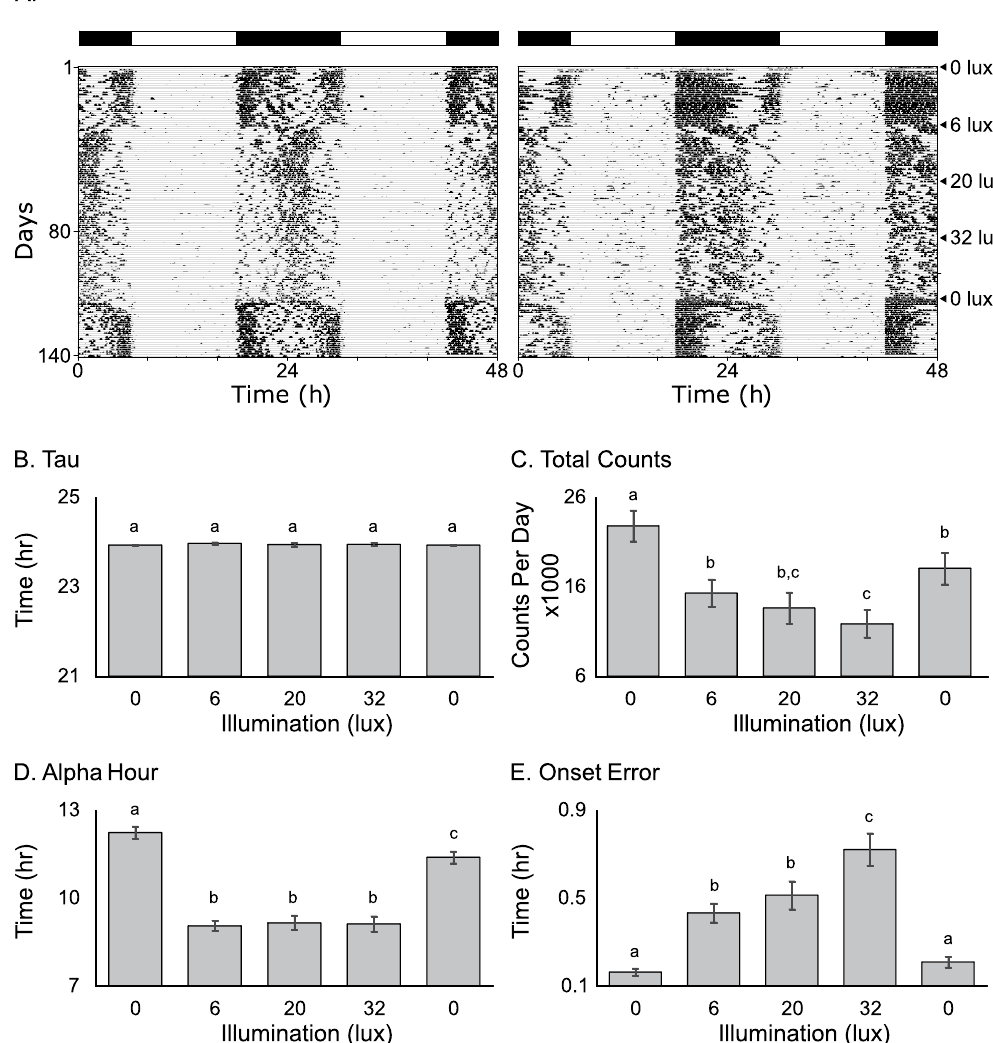
Figure 2. Increasing levels of nocturnal light significantly change mammalian locomotor behavior. Double plotted actograms of two male mice ( A ) clearly demonstrate that increasing levels of nocturnal light change overall activity patterns in these animals. Time on the x-axis represents local time and the light/dark bar at the top of each actogram corresponds to the light (white) and dark (black) phases of the light cycle. Levels of light during the dark phase (black bars) were systematically increased every 4 weeks as depicted on the right of panel A. No significant differences were found between male and female animals (n = 8 and 7, respectively). Quantification of these patterns demonstrate that while the period (Tau; B ) of locomotor activity is unchanged, the total counts ( C ) and the length of the active phase (Alpha hour; D ) significantly decrease and onset error ( E ) significantly increases with increasing levels of nocturnal light. When animals were returned to < 0.01 lux at the end of the experiment all values trended back toward values seen in the initial < 0.01 lux condition. All values in panels B–D are represented as mean ± SEM. Different letters above each bar represent significant differences with p <